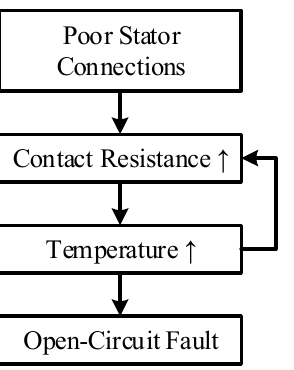
Figure 3. Illustration of stator connection failure mechanism.